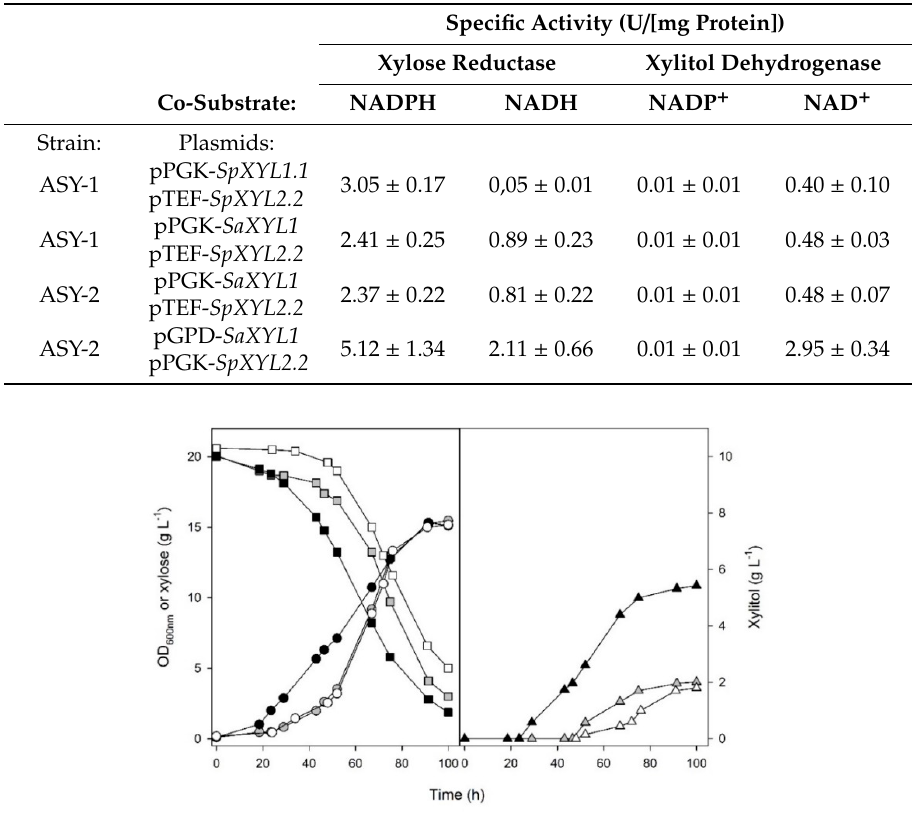
Table 5. Xylose reductase and xylitol dehydrogenase activities co-expressed in S. cerevisiae . Specific Activity (U / [mg Protein]) Xylose Reductase Xylitol Dehydrogenase